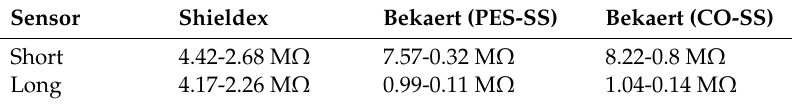
Table 3. Measured sensors resistance ranges at 2 kHz.